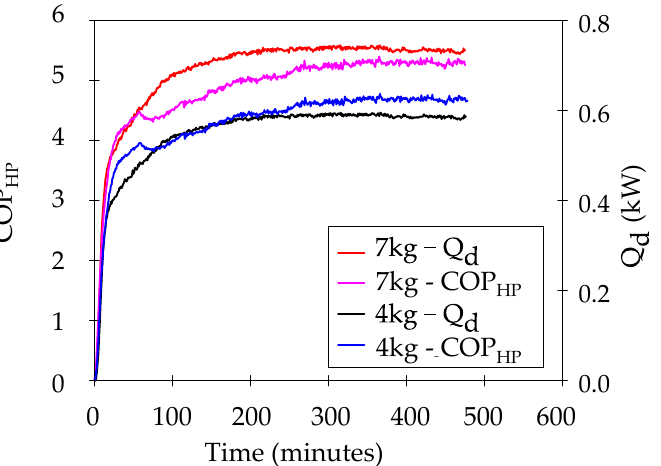
Figure 17. Variation in COP HP and the sensible heat transfer rate at the condenser for the old design.